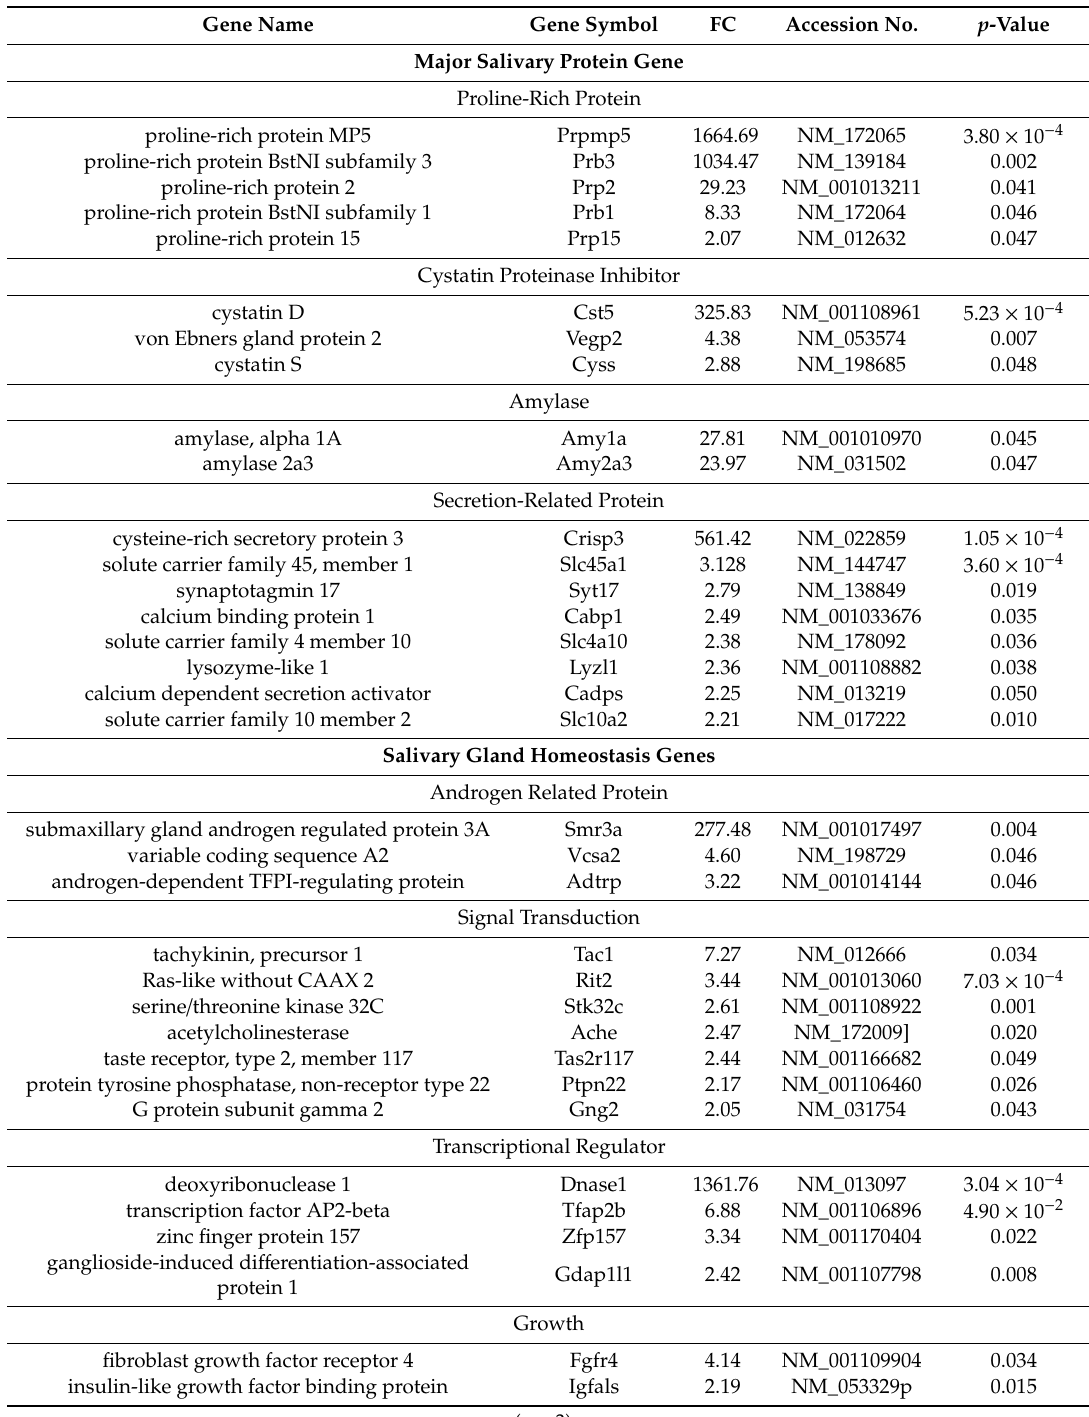
Table 3. Genes upregulated by > 2.0-fold ( p < 0.05) in SLGs from LHK-treated group compared to those from water-treated